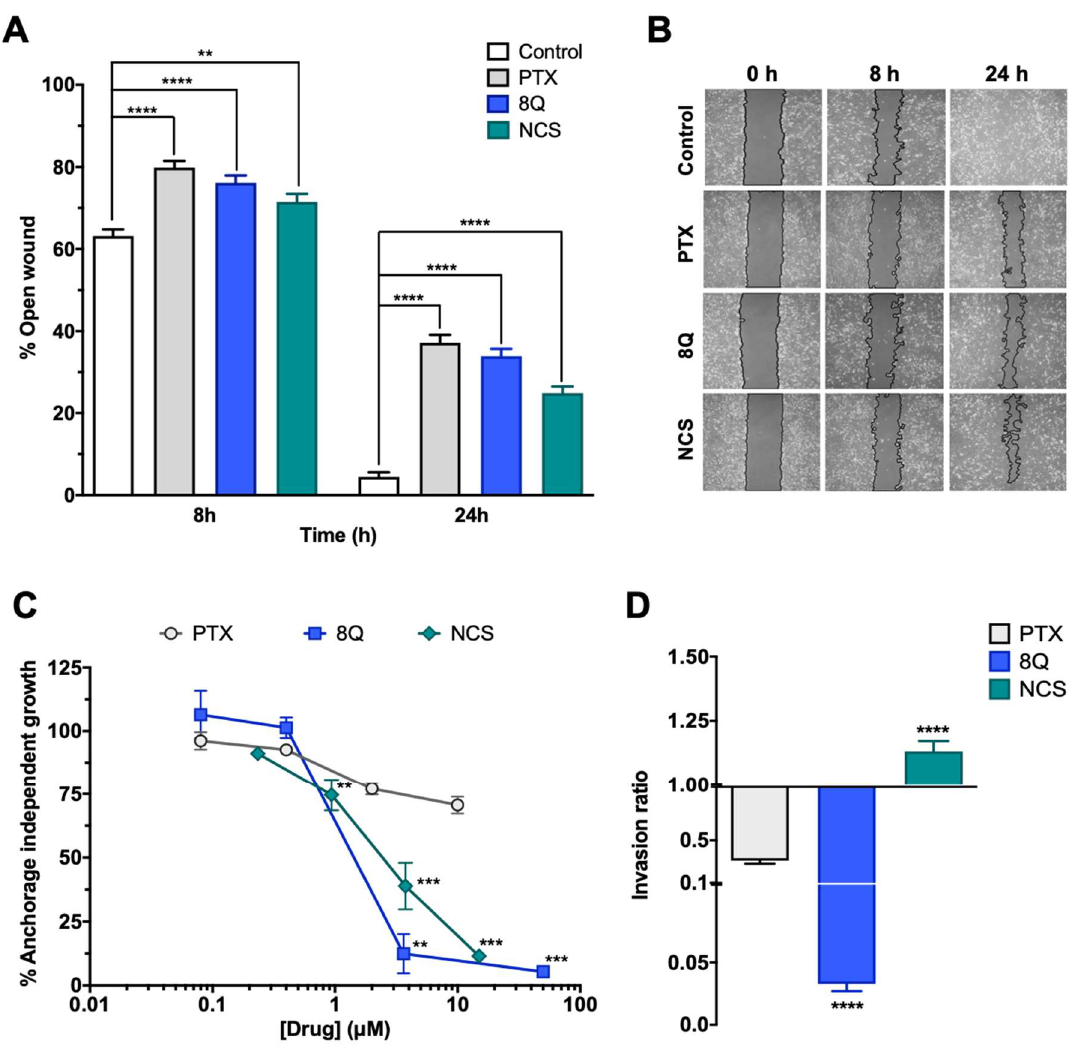
Figure 3. Efficacy of 8Q and NCS inhibiting migration, tumorigenicity and invasion in MDA-MB-231 cell line. ( A ) Wound healing assay showing the percentage of open wounds after 8 and 24 h of treatment with 1 µM PTX, 25 µM 8Q and 0.5 µM NCS. ( B ) Representative images of the wound closing over time. The wound area has been outlined in black and pseudocolored in gray. ( C ) Cell growth in soft agar (anchorage-independent growth) upon treatment with different concentrations of PTX, 8Q and NCS. ( D ) Rate of cell invasion in Matrigel after 24 h treatment of 1 µM PTX, 25 µM 8Q and 0.5 µM NCS. All graphs show the mean ± SEM of at least three independent experiments. All statistical analyses were performed compared to the control non-treated cells (** p < 0.01, *** p < 0.001, **** p < 0.0001).